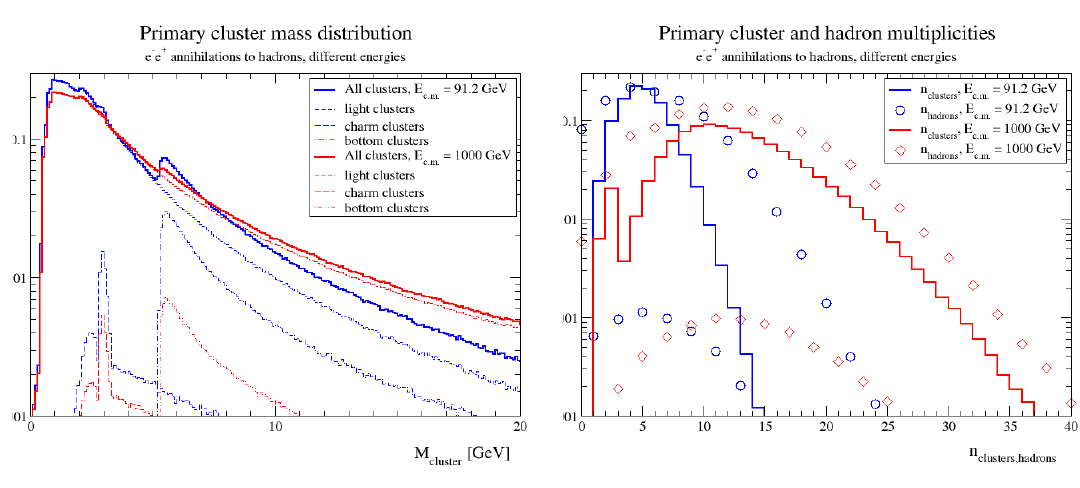
Figure 1: Mass (left panel) and multiplicity distributions (right panel) of primary clusters and hadrons in e + e − → hadrons events at varying centre-of-mass